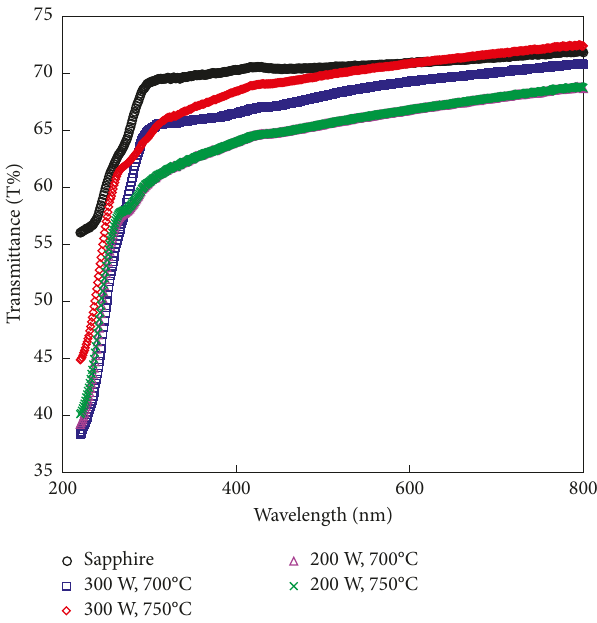
2 versus h Figure 6: α h ] dependence of Ga 2 O 3 thin films grown ( ) at different substrate temperatures and a 1.5sccm O 2 flux. 402 ν <− > Table 2: Optical bandgaps of β -Ga 2 O 3 thin films grown at 300W at different temperatures and oxygen fluxes.